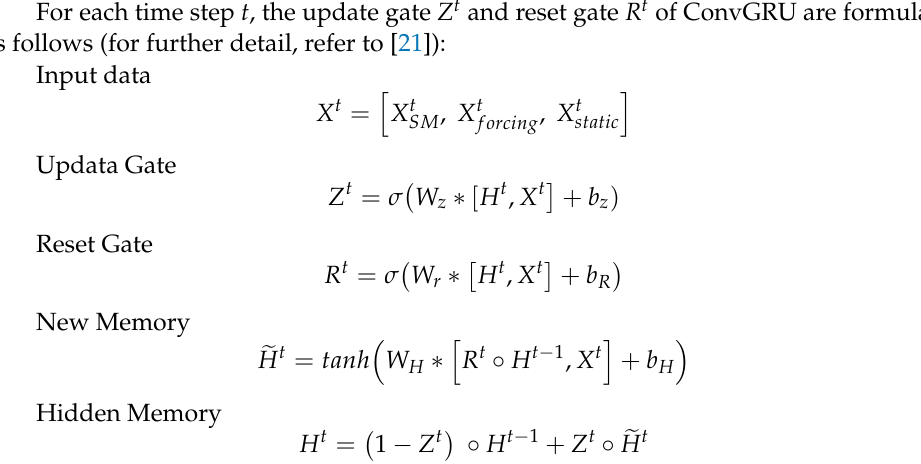
Figure 1. Inner structure of ConvGRU. X is the input and H is the hidden layer.